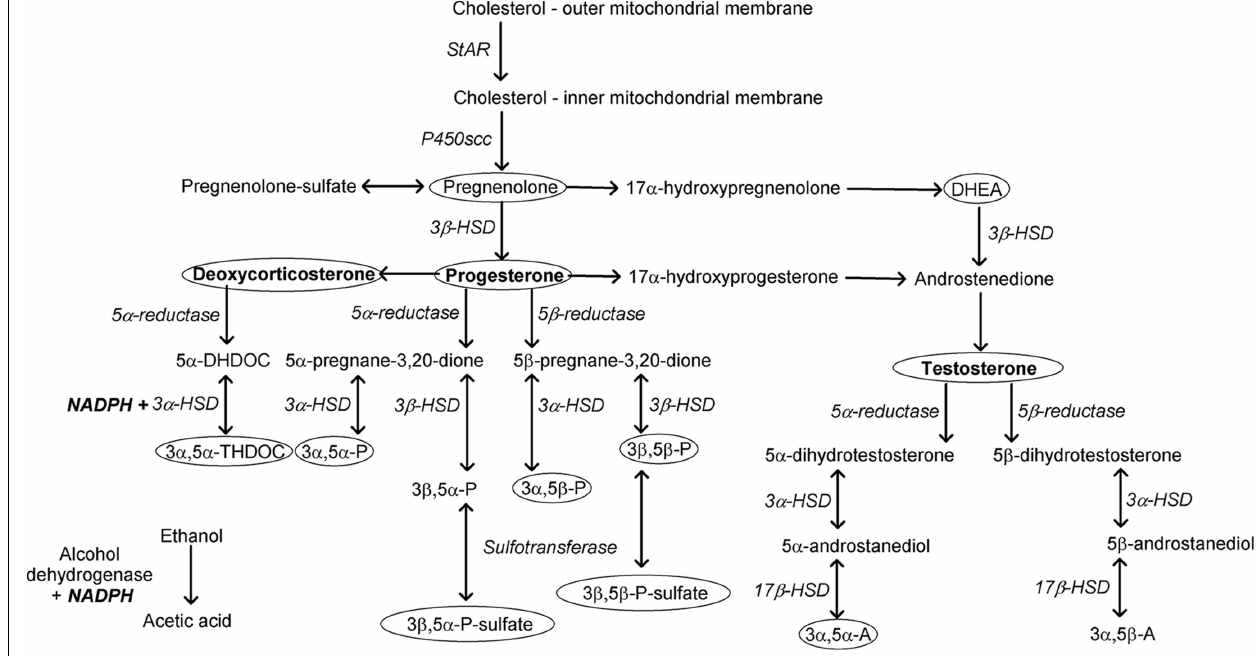
FIGURE 1 | Neurosteroids modulating GABAergic neurotransmission are produced by the precursor steroids deoxycorticosterone (3 α ,5 α -THDOC, allotetrahydrodeoxycorticosterone), progesterone (3 α ,5 α -P, allopregna- nolone; 3 α ,5 β -P, pregnenolone; 3 β ,5 α -P, epiallopregnanolone; 3 β ,5 β -P, epipregnanolone), and testosterone (3 α ,5 α -A, androsterone; 3 α ,5 β -A, etiocholanolone) via the sequential actions of reductase and hydroxy- steroid dehydrogenase enzymes. Ellipses highlight steroids known to